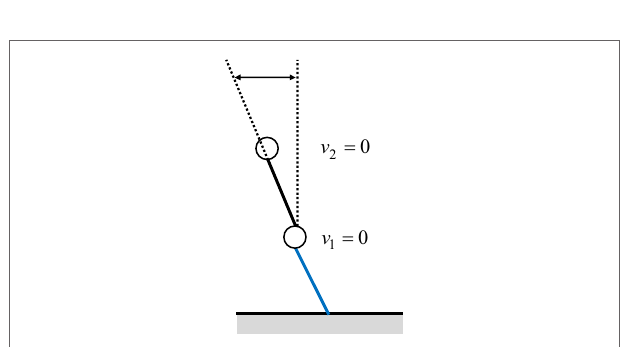
FigUre 15 | Deformation mode and velocity at the phase (a) (upper bound case).